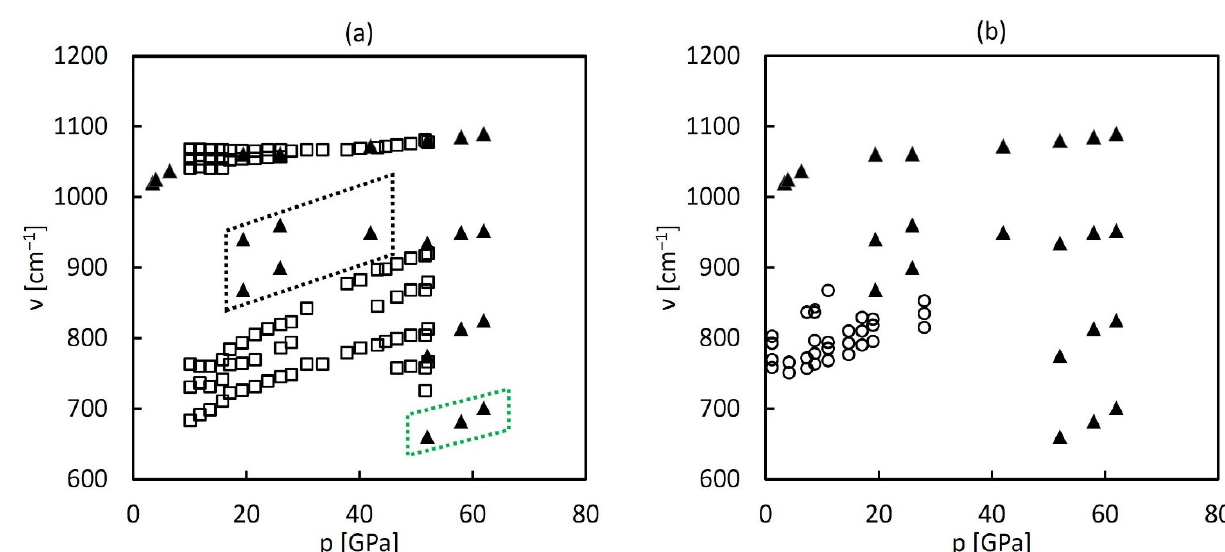
Figure 5. Comparison of new bands appearing in spectra from experiments A and B (solid triangles) with: ( a ) known bands from solid chlorine (this work, hollow squares), ( b ) known bands from solid CCl 4 (ref. [41], hollow circles). Black dashed parallelogram indicates bands unaccounted for by Cl 2 or CCl 4 . Green dashed parallelogram indicates bands possibly originating from chlorinated diamond. Reproduced with permission from ref. [41]. 2014 AIP Publishing.